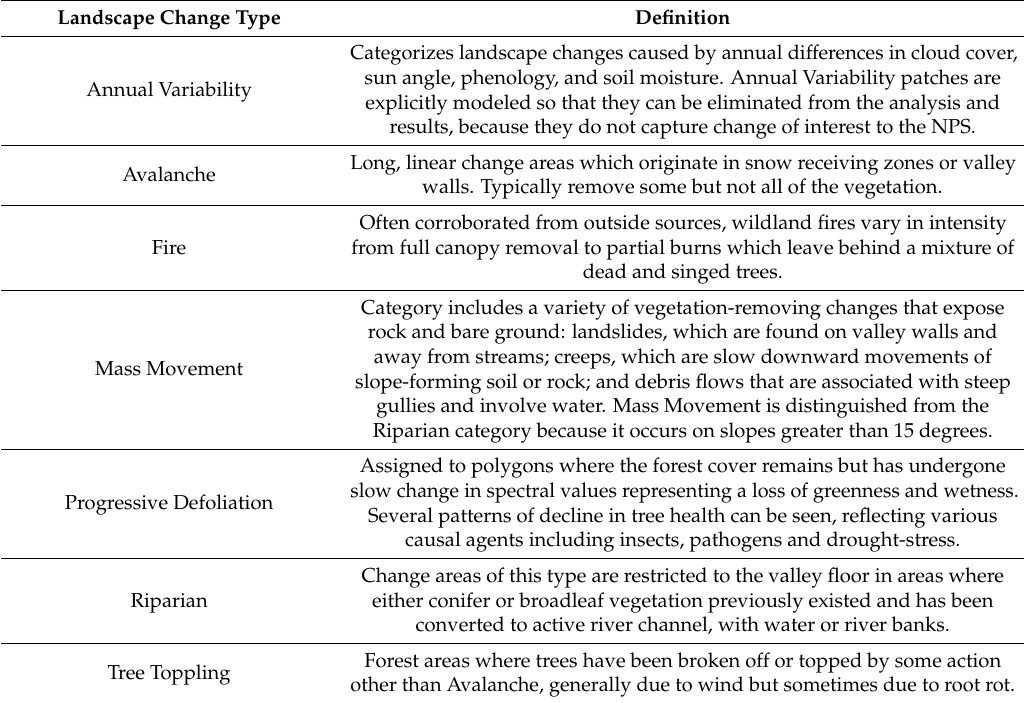
Table 1. List of landscape change types and